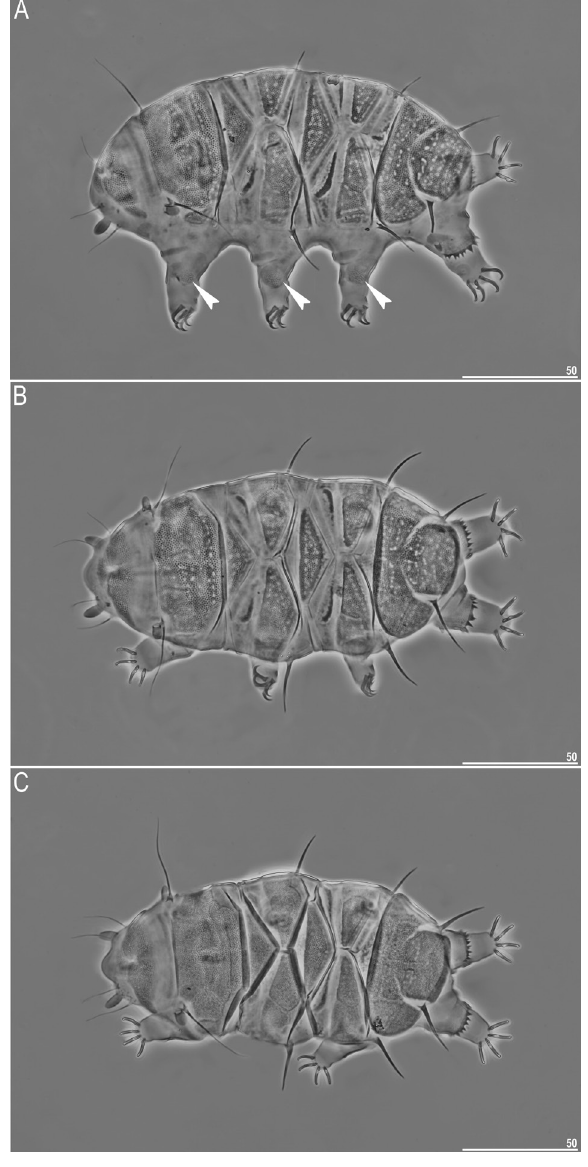
Figure 2. Morphology of males of E. masculinus sp. nov. (PCM). A. allotype (dorsolateral view, arrowheads indicate ar- eas with densely packed pillars in legs); B. paratype with fully developed sculpturing (dorsal view); C. paratype with poorly developed epicuticular layer of sculpturing (dorsal view). See Table 4 for the phenotypic comparison between females and males. All scale bars in µm.